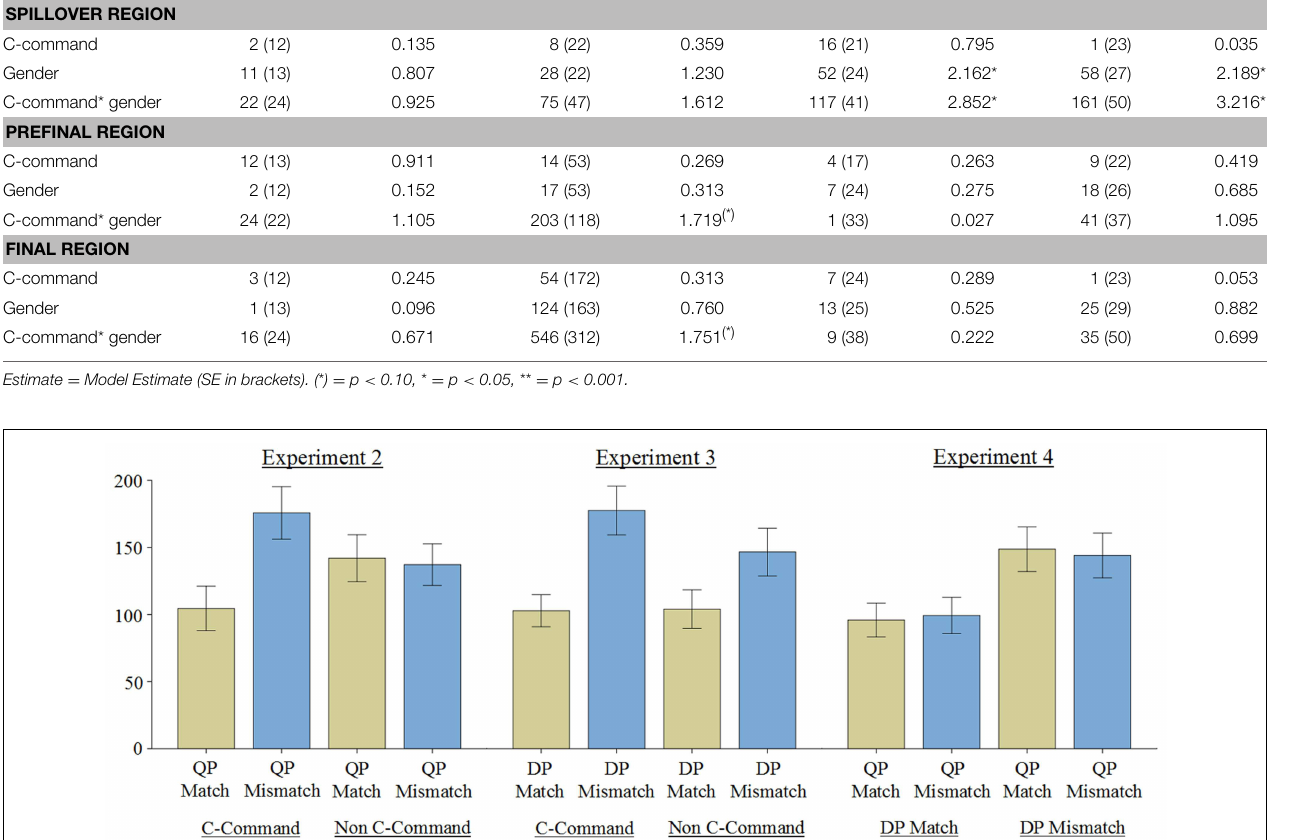
but only when the QP c-commanded the pronoun. Similar